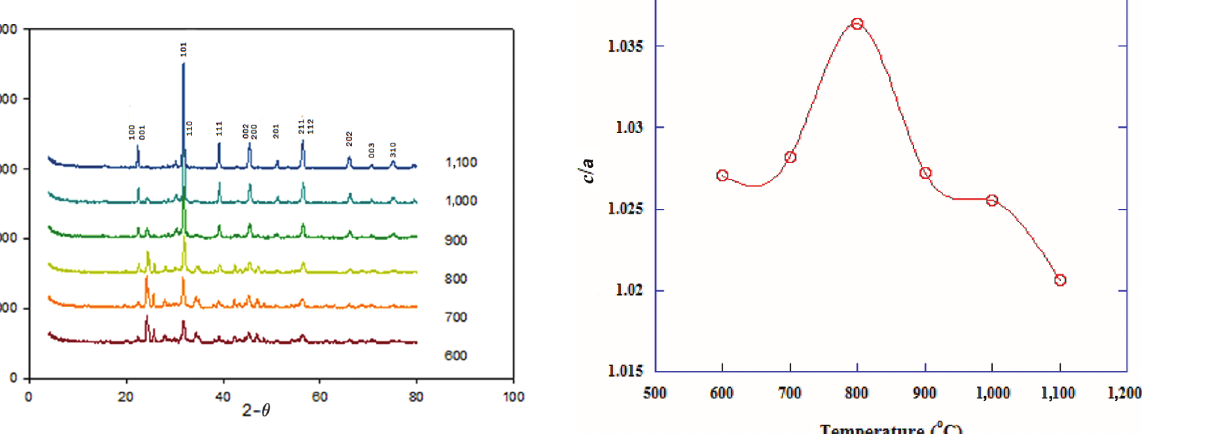
Figure 3: Tetragonality ( c / a ) for prepared sample at different annealing